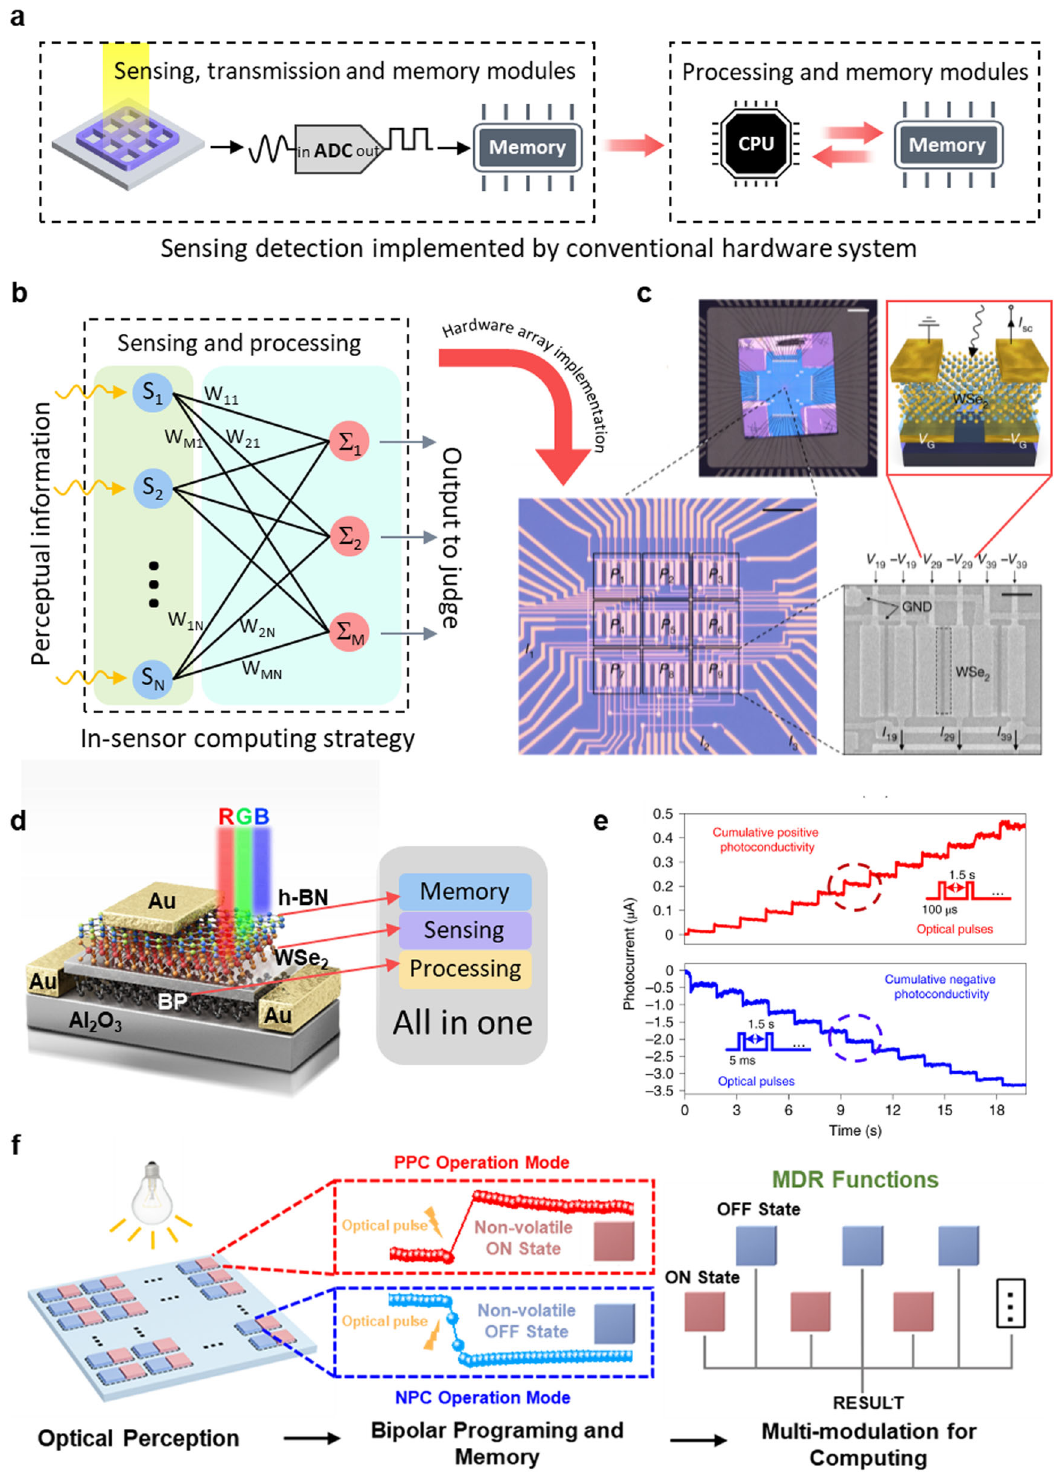
Fig. 11 Arrays integrated with sense. a Illustration of the chain fl ow for sensing detection by the traditional hardware. b Schematic diagram of the single-layer arti fi cial neural network as the classi fi er implemented by 2D sensors. c Macroscopic images of the ANN sensor-based array. c are reproduced from ref. 171 . d Schematic diagram of the all-in-one retinomorphic hardware device based on 2D materials. e Cumulative positive and negative photoconductivity characteristics of the retinomorphic devices. f Principle of Motion detection and recognition precessed by retina-inspired 2D retinomorphic hardware. d – f are reproduced from ref. 173